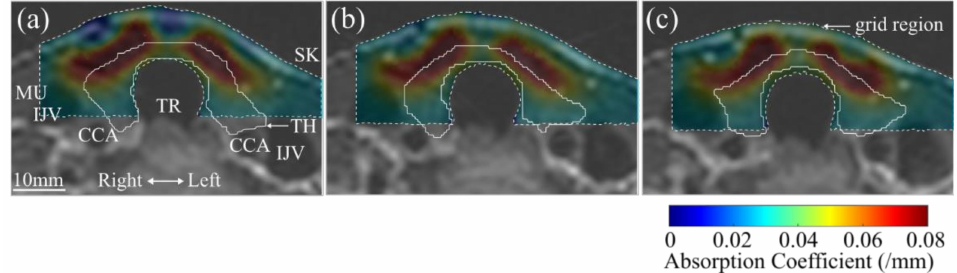
Figure 4. Tomographic images of the absorption coefficient at 801 nm by the trachea–tissue boundary grid on horizontal sections at ( a ) 3 mm above the middle of the thyroid isthmus, ( b ) the middle of the thyroid isthmus, ( c ) 3 mm below the middle of the thyroid isthmus. The T2-weighted MR images are shown in the background. The shape of the thyroid is outlined by the white line. In Figure 4a, positions of the muscle (MU), internal jugular vein (IJV), common carotid artery (CCA), trachea (TR), thyroid (TH), and skin (SK) are shown. In Figure 4c, the grid region is denoted by the dashed white line.